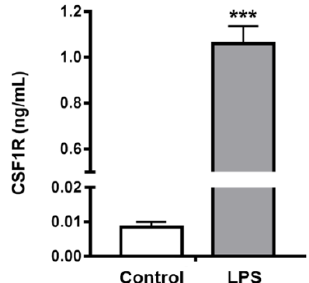
Figure 3. CSF1R expression levels in brain tissues from control (white) and LPS mice (grey). Brain tissues were collected on the third day after i.p. injection of saline (control) or LPS into mice. Data represent the mean ± S.D. (n = 3). *** p < 0.001.